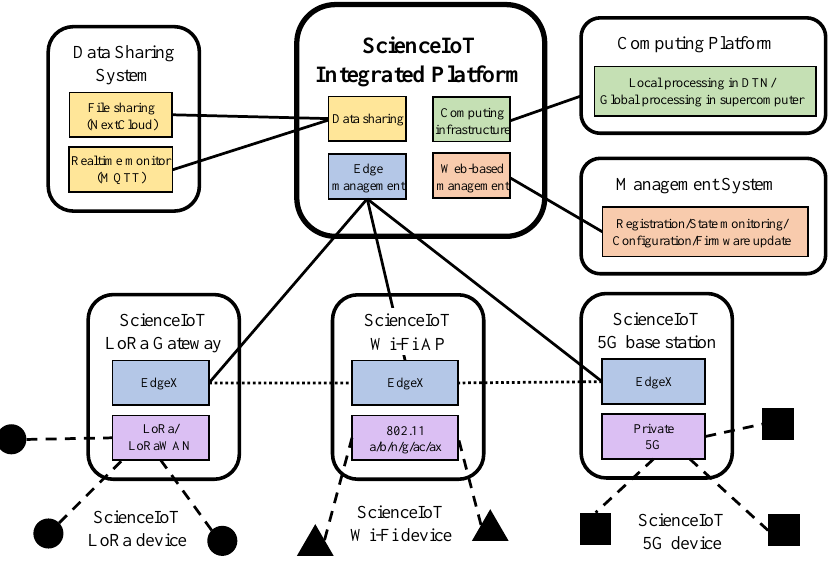
Figure 17. Comprehensive vision of